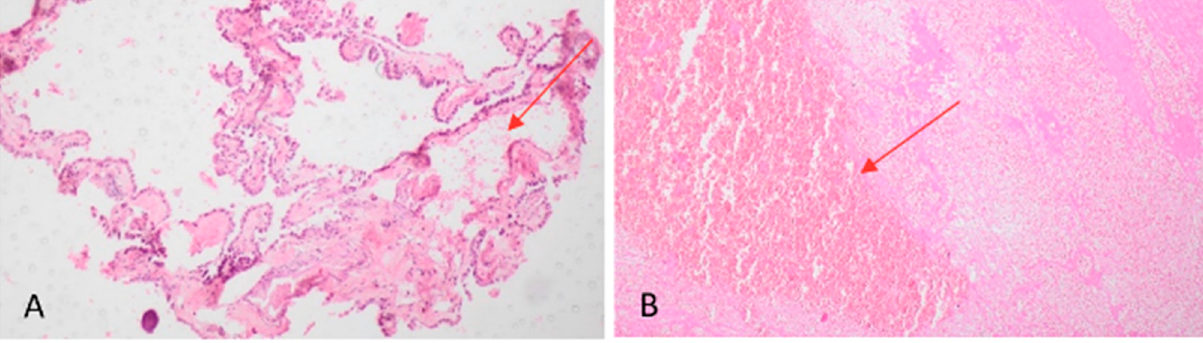
Figure 2. Histology of brain. ( A ) choroid plexus with severe subepithelial edema (red arrow) (H–E ×10); ( B ) intraventricular hematoma in early stage of organization (red arrow) (H–E ×10); ( C ) lysed erythrocytes (red arrow) (H–E ×20); ( D ) flaking choroidal plexus (red arrow) (H–E ×20). Figure 3. Details of the fibrous capsule characterized by early stage of granulation tissue-type stroma, re-active gliosis, and calcium deposition (red arrow) (H–E ×10). 2.3. Toxicological Analysis Toxicological analysis showed no evidence of drugs or alcohol in bodily fluids and samples of internal organs. 3. Discussion CEIH is a rare entity, and the exact origin is still very challenging for the pathologist [1,3]. It is a disease affecting all ages; the youngest reported patient was 2 months old and the oldest was 80 years old. The mean age is reported to be 41.4 years (standard